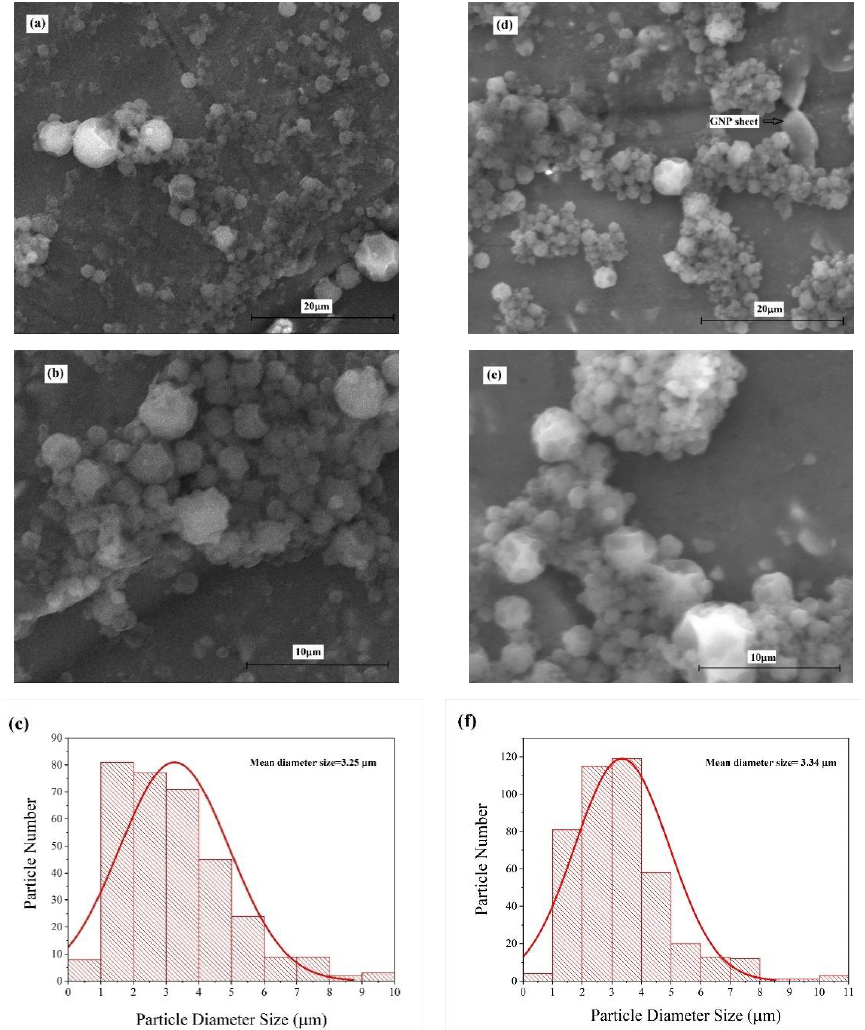
Figure 4. ( a , b ) SEM images and; ( c ) particle size distribution of Cr60@Polyurea; ( d , e ) SEM images; and ( f ) particle size distribution of Cr60@Polyurea-0.1 wt%GNP.